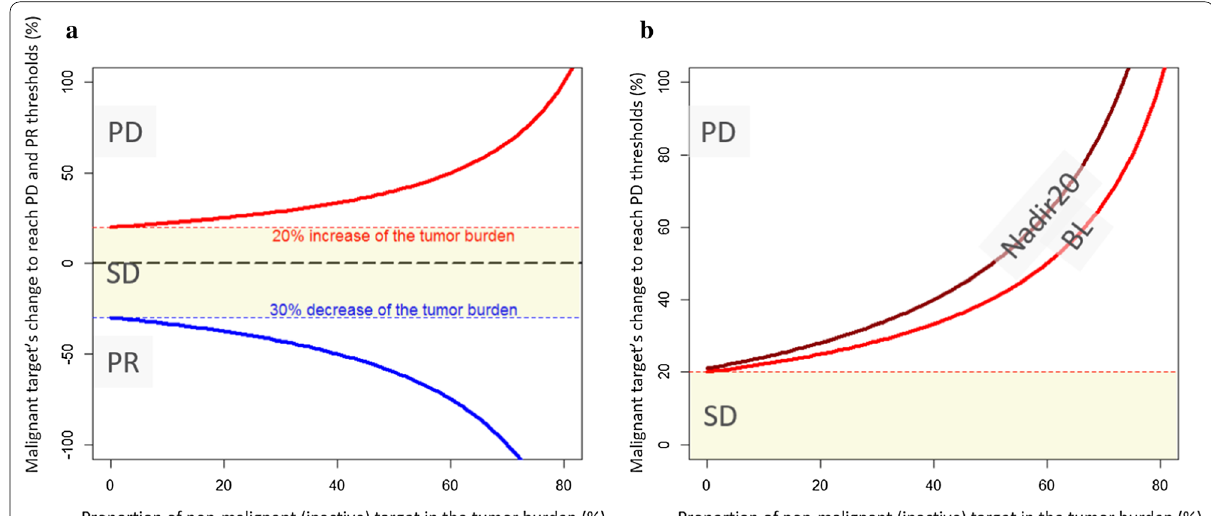
Fig. 3 Mathematical simulation of the proportional change of real malignant target lesions (TL) to trigger progression or response according to RECIST 1.1 thresholds in accordance with the proportion of non‑malignant inactive lesions within the tumor burden. a For the Sum of Diameter thresholds corresponding to a progressive disease 20% (red) and to a partial response 30% (blue), we plotted the proportional change of the + − malignant part of the tumor burden at a given time point with respect to the proportion of inactive tumors in the tumor burden at baseline. We noted that the curve steepens from a proportion of about 50% of inactive lesions while the impact is limited to 20% of NMTL pooled in the tumor burden. b For the Sum of Diameter thresholds corresponding to a progressive disease, we simulated the needed change of malignant target to trigger a progression from baseline (red) (similar to a ) and nadir20 (dark red) after a 20% PR. This scenario decreases even more the sensitivity of